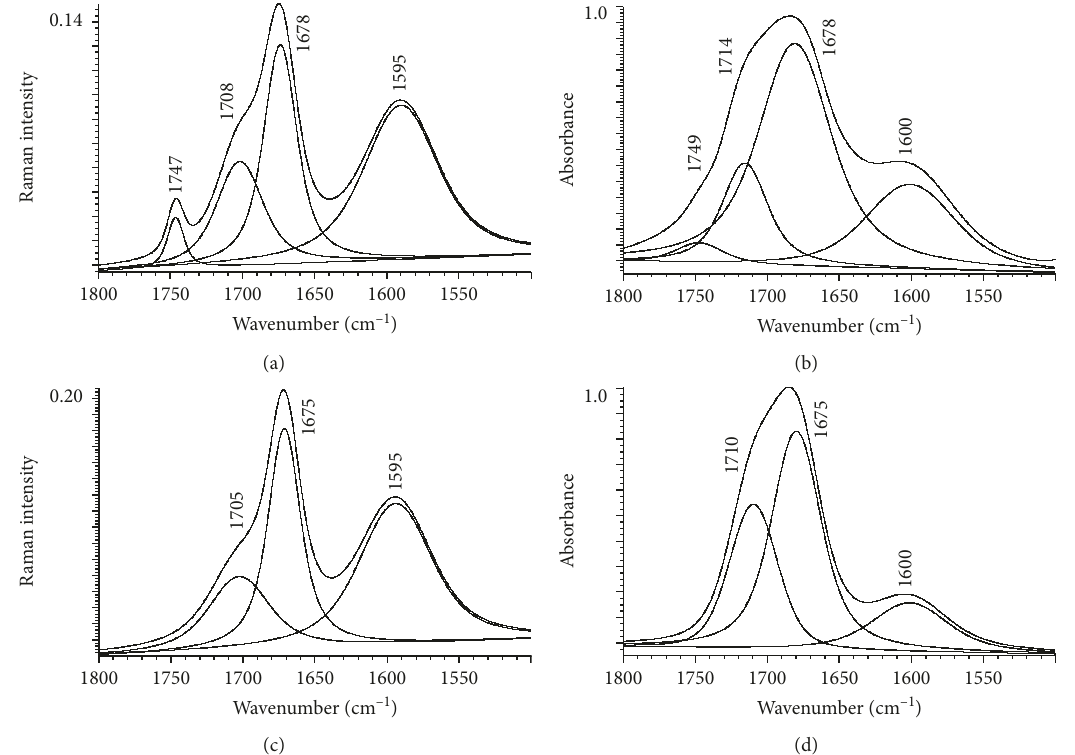
Figure 2: Curve-fitting analyses for Raman (a) and IR (b) spectra of liquid FA (c) and a 1.5mol · kg − 1 GaCl